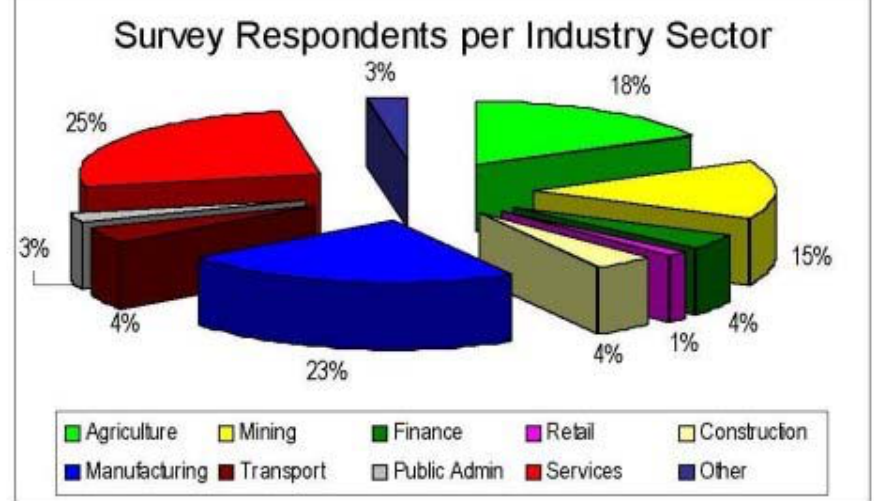
Figure 2 Survey respondents per industry